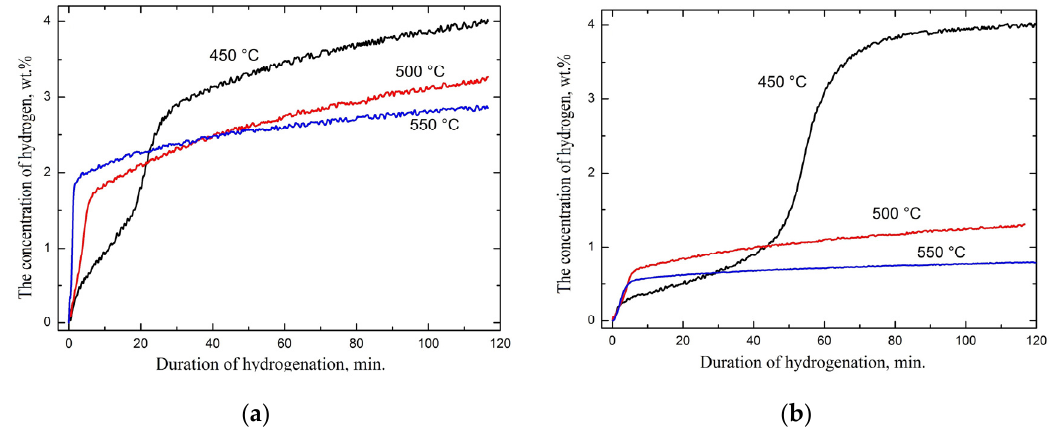
Figure 4. Hydrogen sorption curves at different hydrogen sorption temperatures for the sample with coatings of 20 ( a ) and 80 ( b ) µm, respectively.